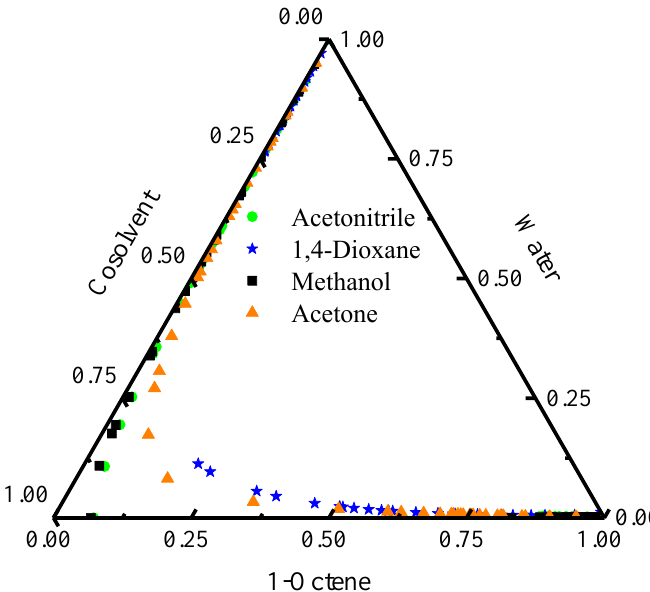
Figure 1. Ternary phase diagram of 1-octene – water – different cosolvents. The kinetics of the direct hydration reaction of 1-octene catalyzed by using an HZSM-5 molecular sieve and with 1,4-dioxane as the cosolvent were analyzed. The ef- fects of stirring speed, reaction temperature, and catalyst amount on the reaction were examined, from which a kinetic model of the reaction was obtained by fitting the ex- perimental data.